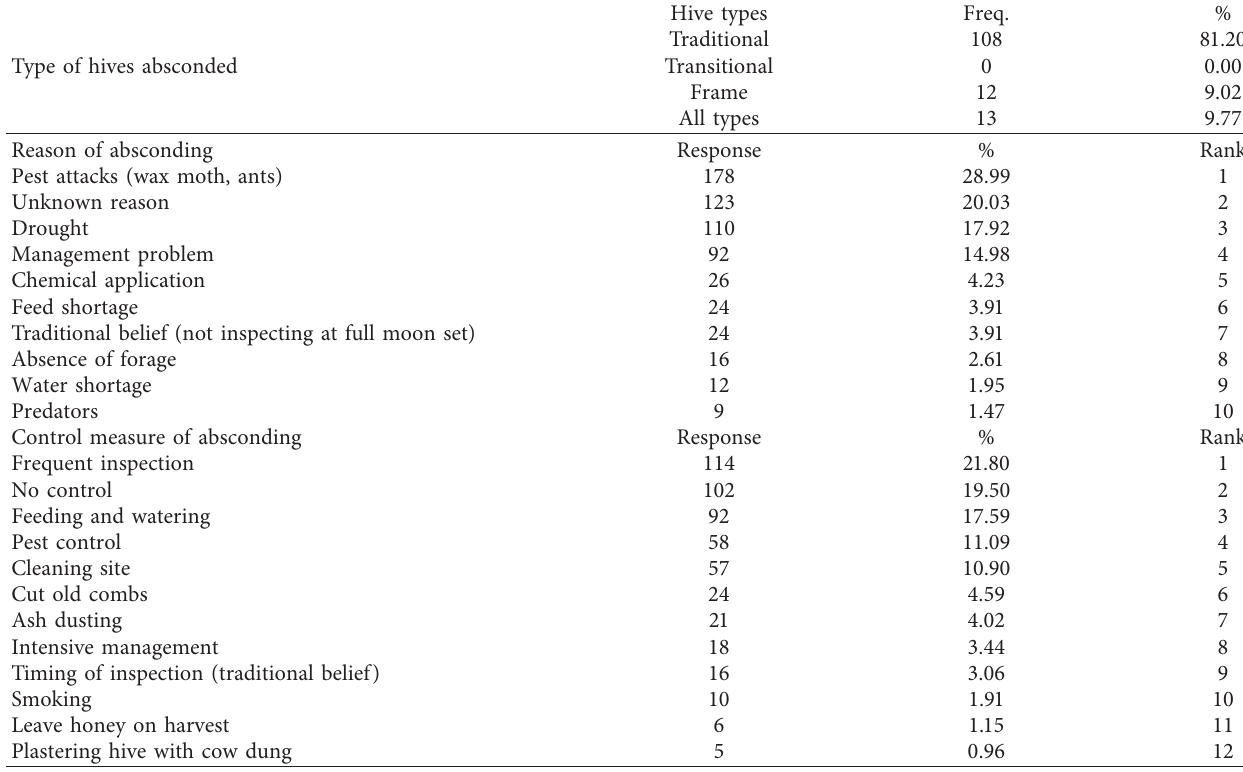
Table 8: Absconding of honeybee colonies in the study